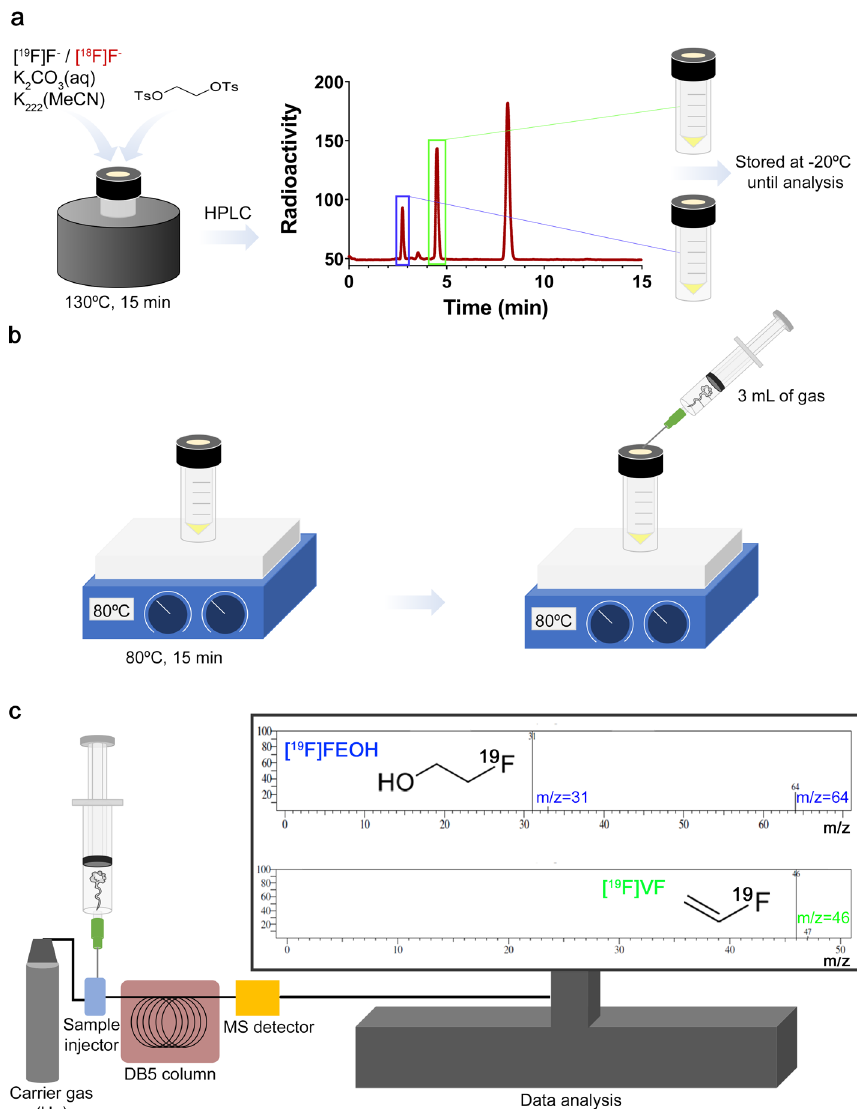
Fig. 3 HS-GC–MS analysis of the cold FEtOTs crude reaction mixture. a [ 18 F]FEtOTs and FEtOTs crude mixtures were co-injected and analyzed in an analytical HPLC using an Agilent Zorbax Eclipse Plus C18 (5 µm, 4.6 250 mm) analytical column; elution with 0.1% TFA water / MeCN, 55:45 at 1 mL/min; and monitored × with a radioactivity detector. Fractions collected at 2.7 min and 4.7 min observed in the radio-HPLC chromatogram were frozen at 20 °C until further analysis. b Samples were defrosted and heated at 80ºC, − and 3 mL of gas was extracted from each collected sample. c Samples were analyzed by HS-GC–MS. Analysis showed the characteristic m/z ratios 31 and 64 corresponding to 2-fluoroethanol ([ 19 F]FEOH), and m/z ratios 46 for vinyl fluoride ([ 19